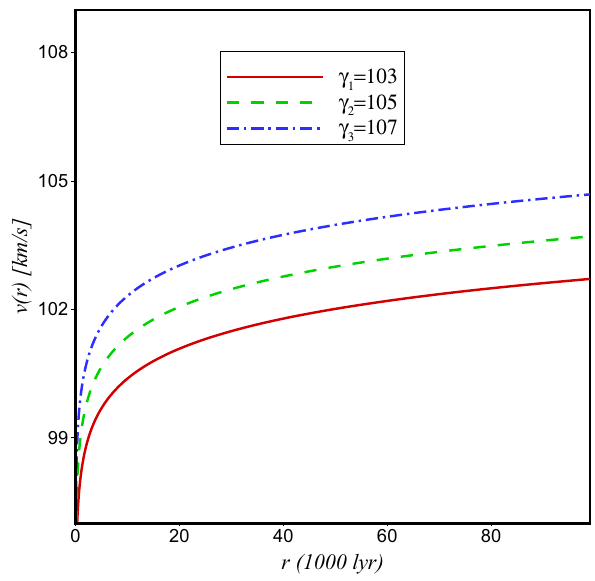
Fig. 2 The speed of a test particle around a spiral galaxy in terms of distance for β = 0 . 49 and different values of galaxy mass M i = γ × 10 9 M (cid:12) i